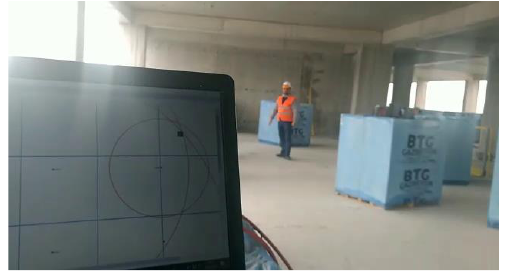
Figure 6. RTLS application in working area.